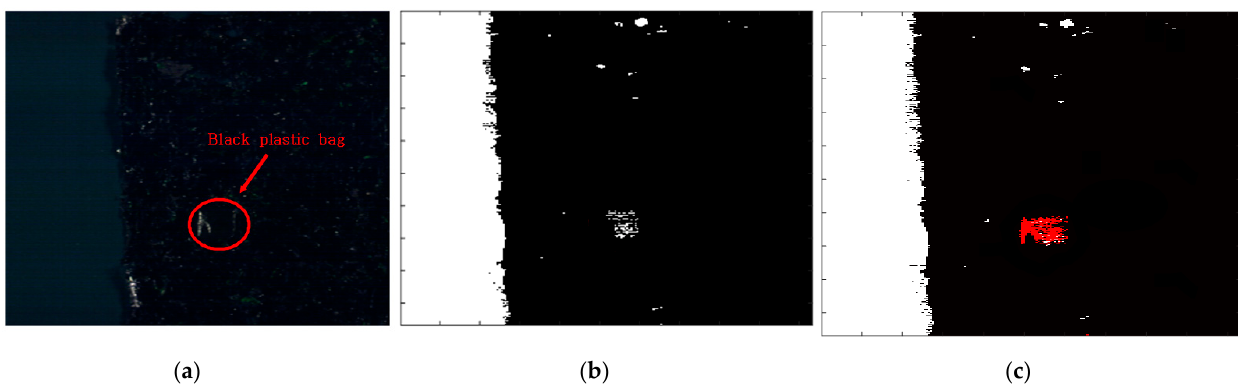
Figure 8. Result of standardization ( a ) Seaweed ( b ) Conveyor belt.